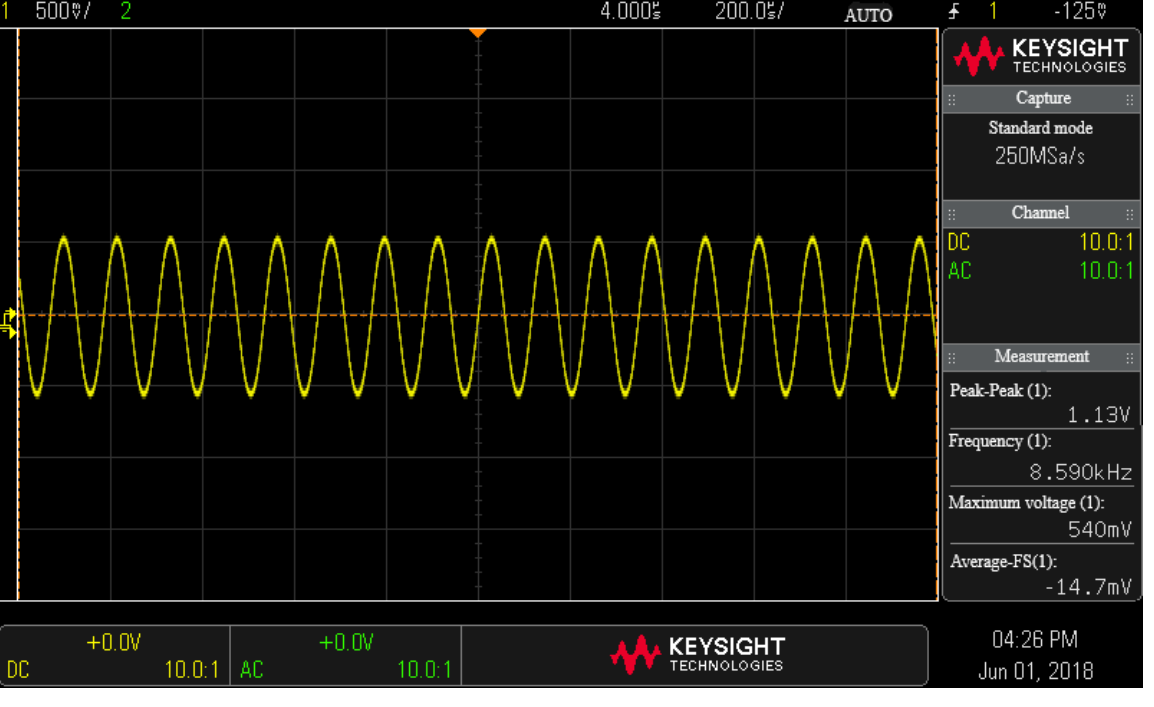
Figure 14. Time domain test chart for driving signal.